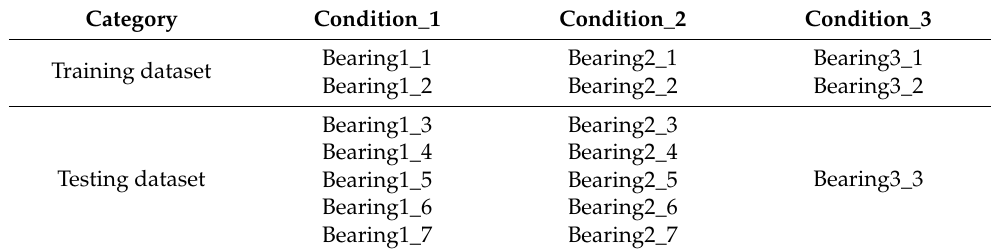
Table 2. Description of the PHM2012 dataset.